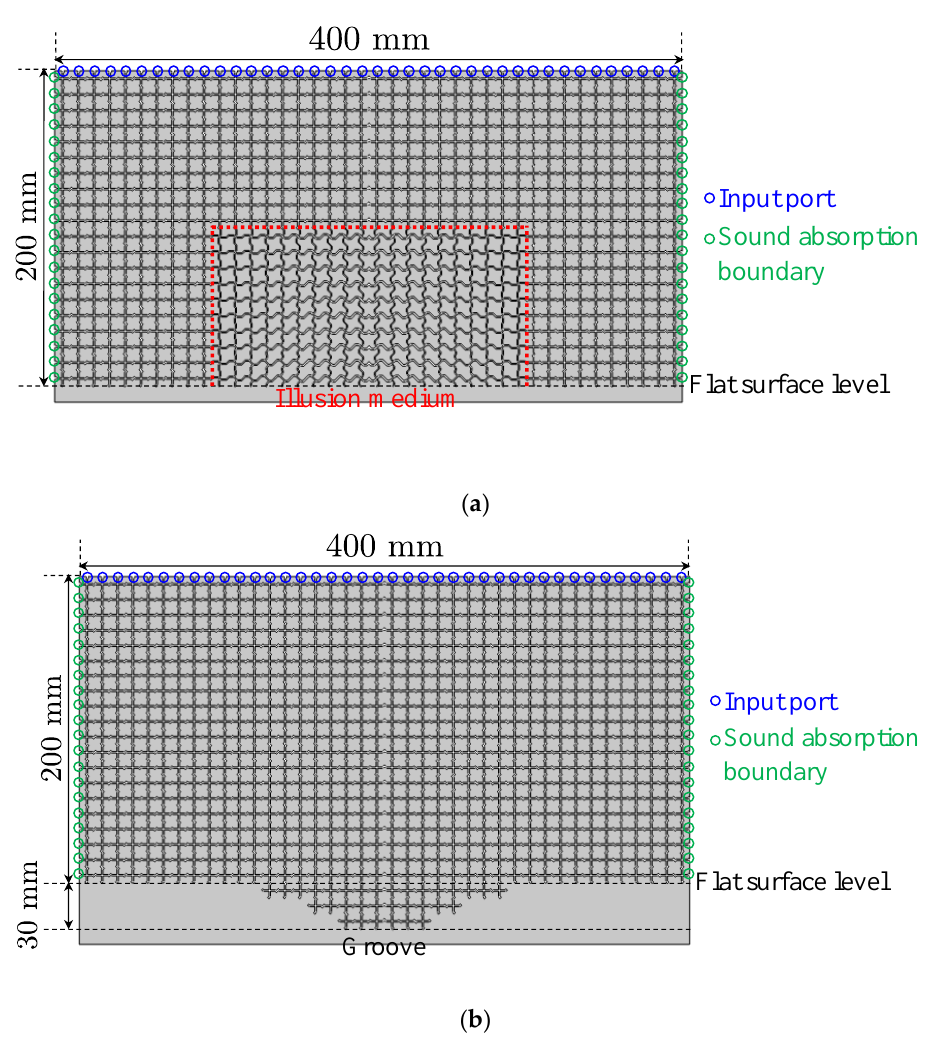
Figure 14. Full-wave simulation setup. ( a ) Acoustic illusion medium; ( b ) groove. The designed structures in Figure 11a,b are placed at the center of the bottom of the background medium area (400 mm × 200 mm). In the case of ( b ), the groove is on the lower position than the flat surface level. The bottom boundaries are set as the rigid body walls.